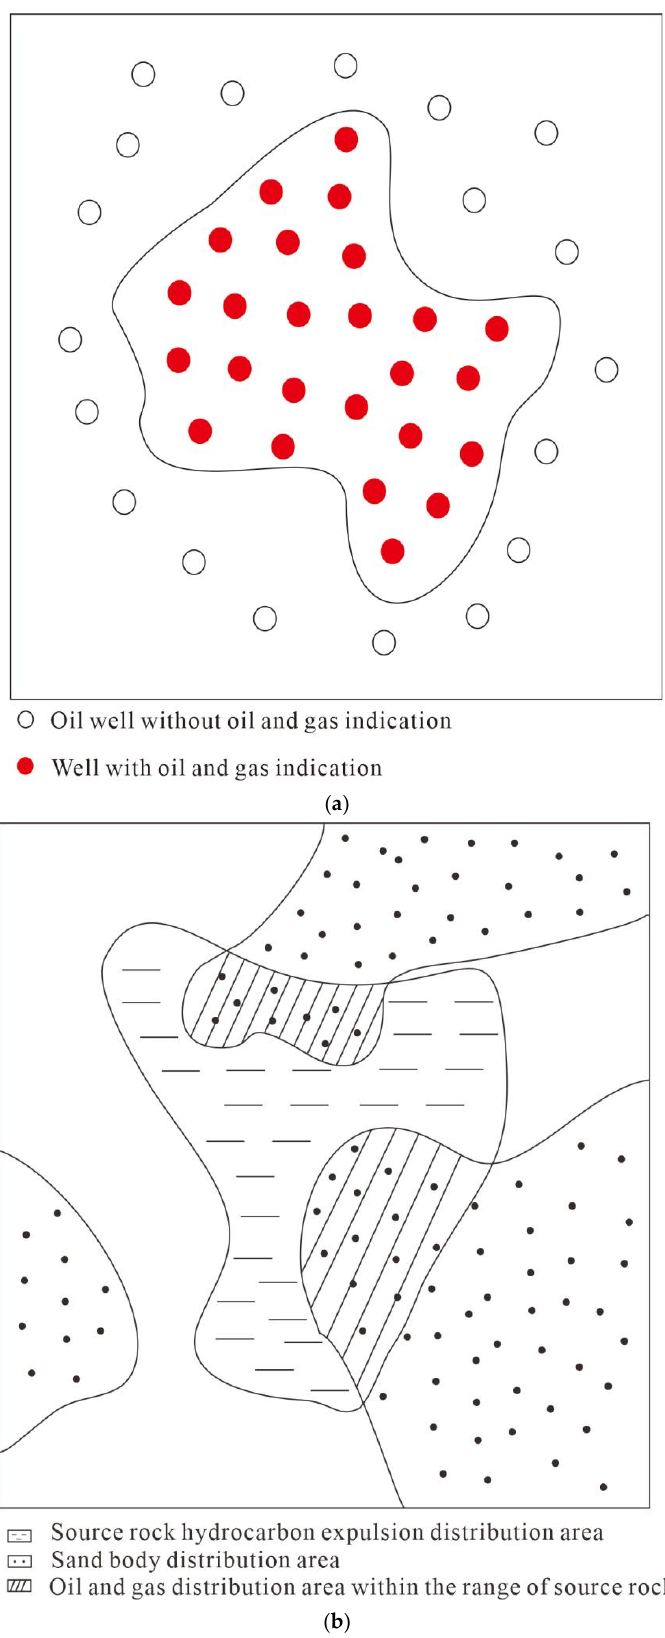
Figure 3. Diagram of identifying oil and gas distribution at deep basin. ( a ) Hydrocarbon distribution outside source rocks. ( b ) Hydrocarbon distribution within source